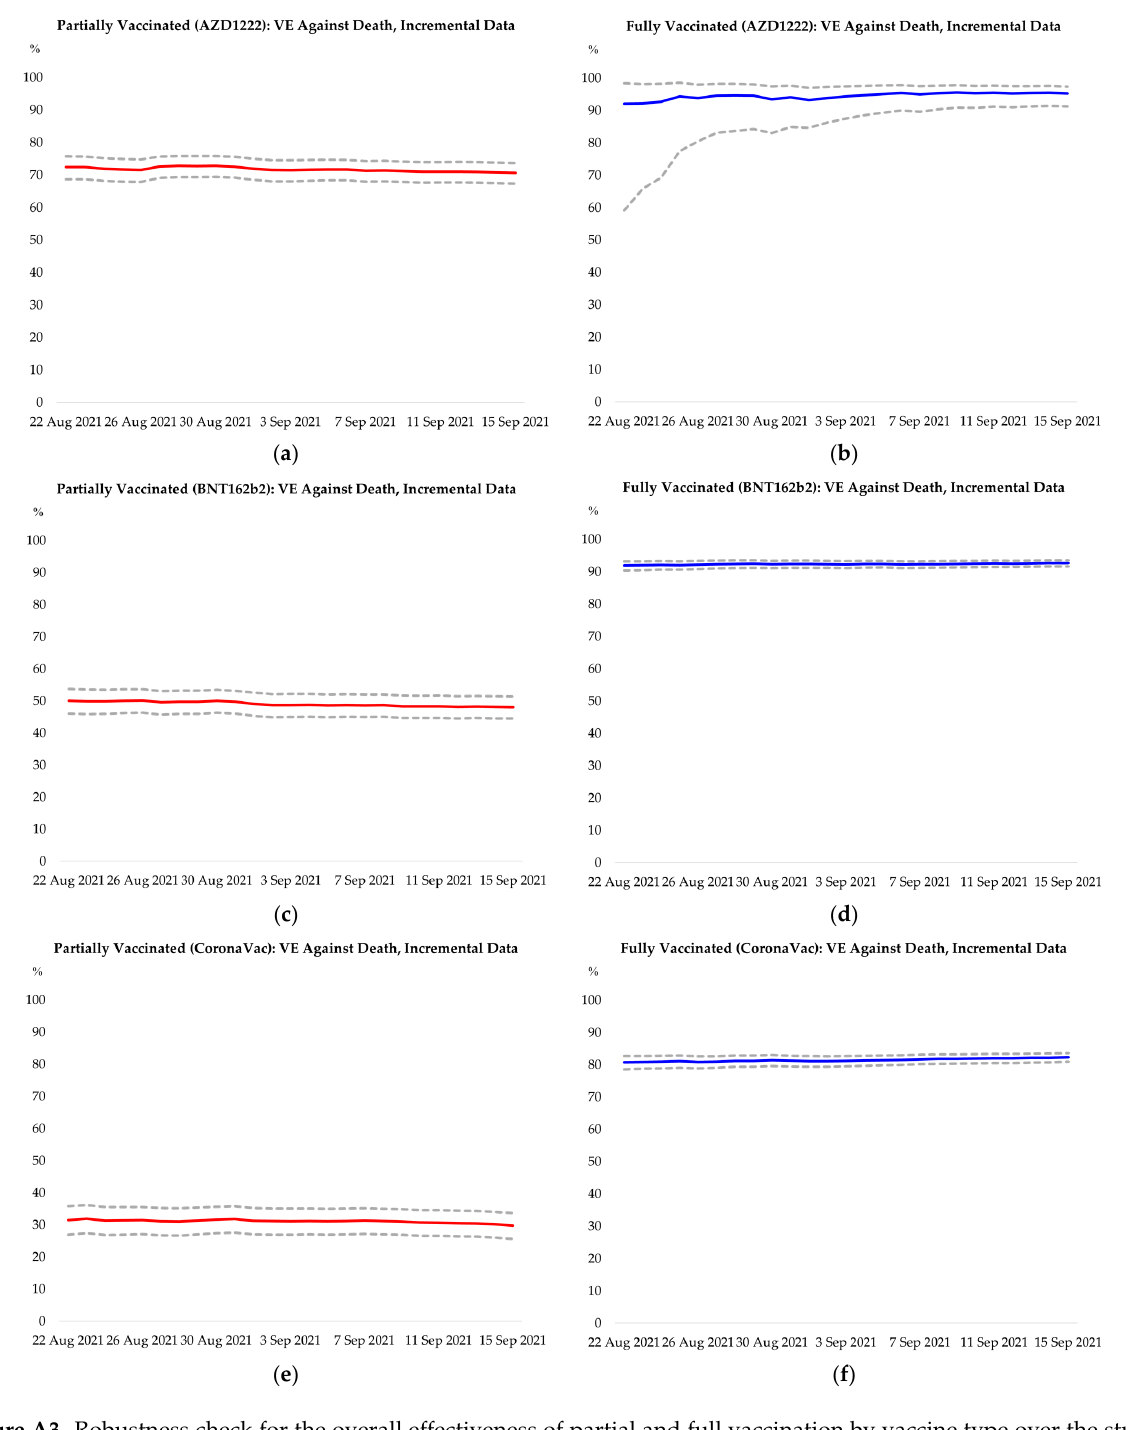
Figure A3. Robustness check for the overall effectiveness of partial and full vaccination by vaccine type over the study period, with line plots representing the effectiveness for COVID-19-related death estimated with data from 1 April 2021 up to the corresponding day on the horizontal axis; dotted lines show the 95% confidence interval. ( a ) Effectiveness of partial vaccination against death for AZD1222; ( b ) Effectiveness of full vaccination against death for AZD1222; ( c ) Effectiveness of partial vaccination against death for BNT162b2; ( d ) Effectiveness of full vaccination against death for BNT162b2; ( e ) Effectiveness of partial vaccination against death for CoronaVac; ( f ) Effectiveness of full vaccination against death for